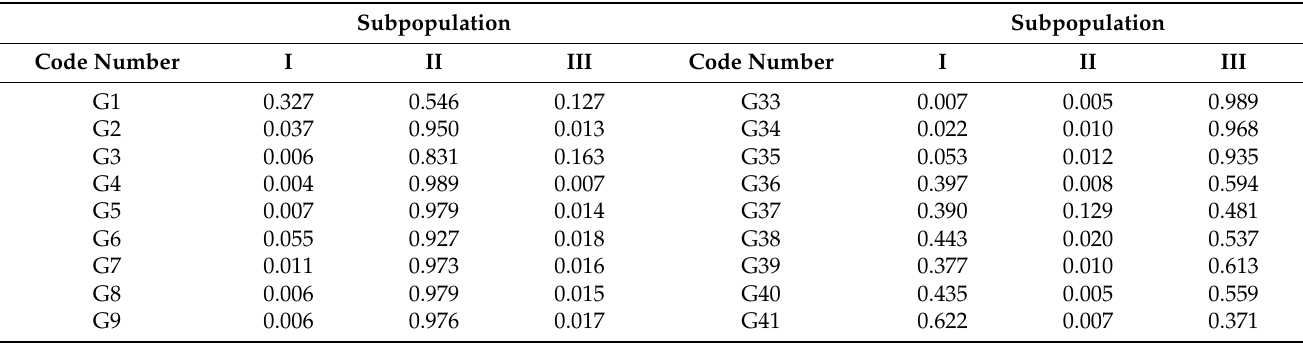
Figure 4. Line graphs from the mixture model of Ln P (D) and ∆ K for wheat populations; a: average value of the Ln P (D) statistics generated by the structure at each value of K; b: DK. Table 7. Membership coefficients of three subpopulations of wheat varieties.